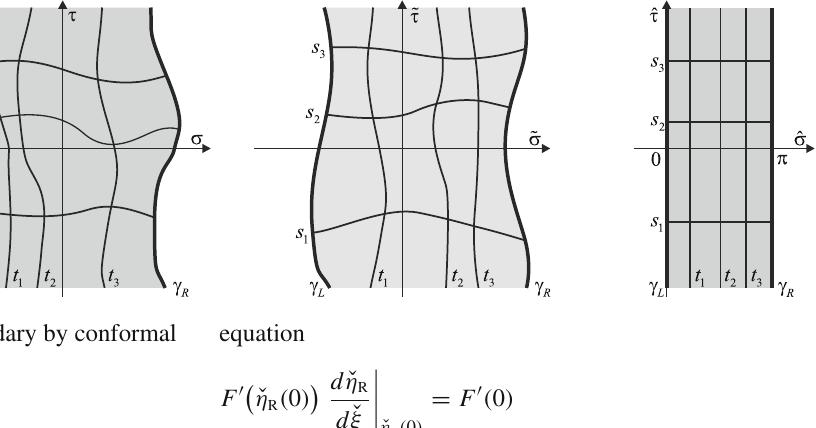
Fig. 1 Open string worldsheet in different coordinates (τ,σ) , ( ˜ τ, ˜ σ) , and ( ˆ τ, ˆ σ) . Three integral curves are shown both for timelike t and spacelike s vector